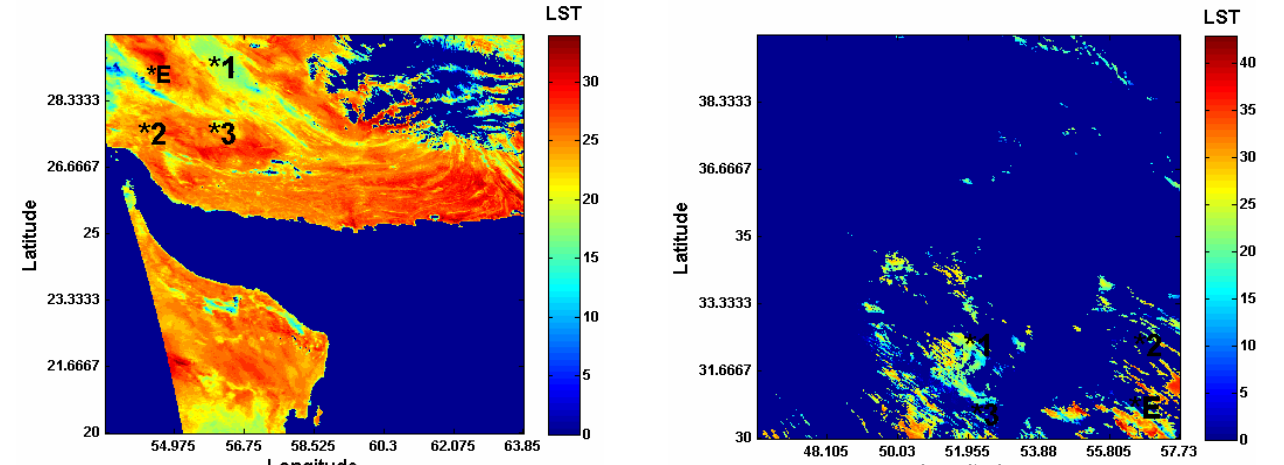
Figure 6. Same as Figure 4 but for the Borujerd earthquake (31 March 2006) from 01 March to 15 3